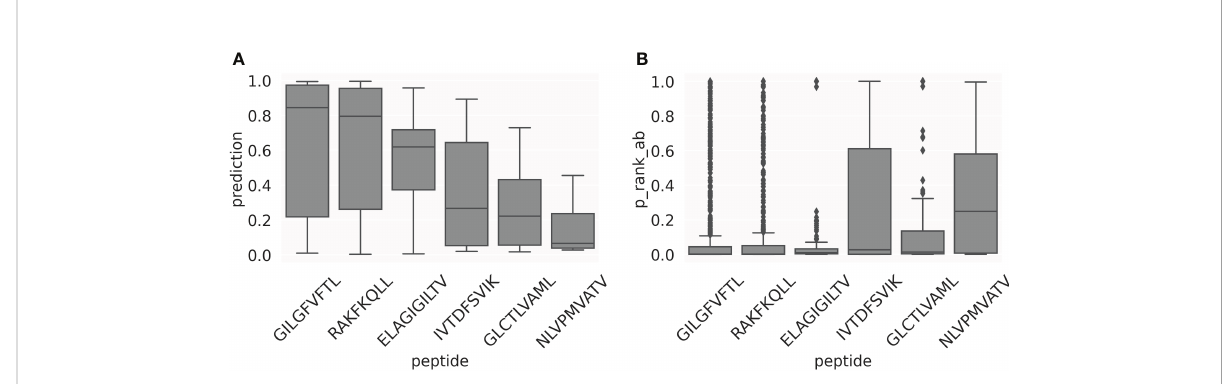
FIGURE 8 Motivation for using percentile ranks. Box-plots of the prediction scores (A) and percentile rank values (B) for the set of positive TCRs in the test CV sets.